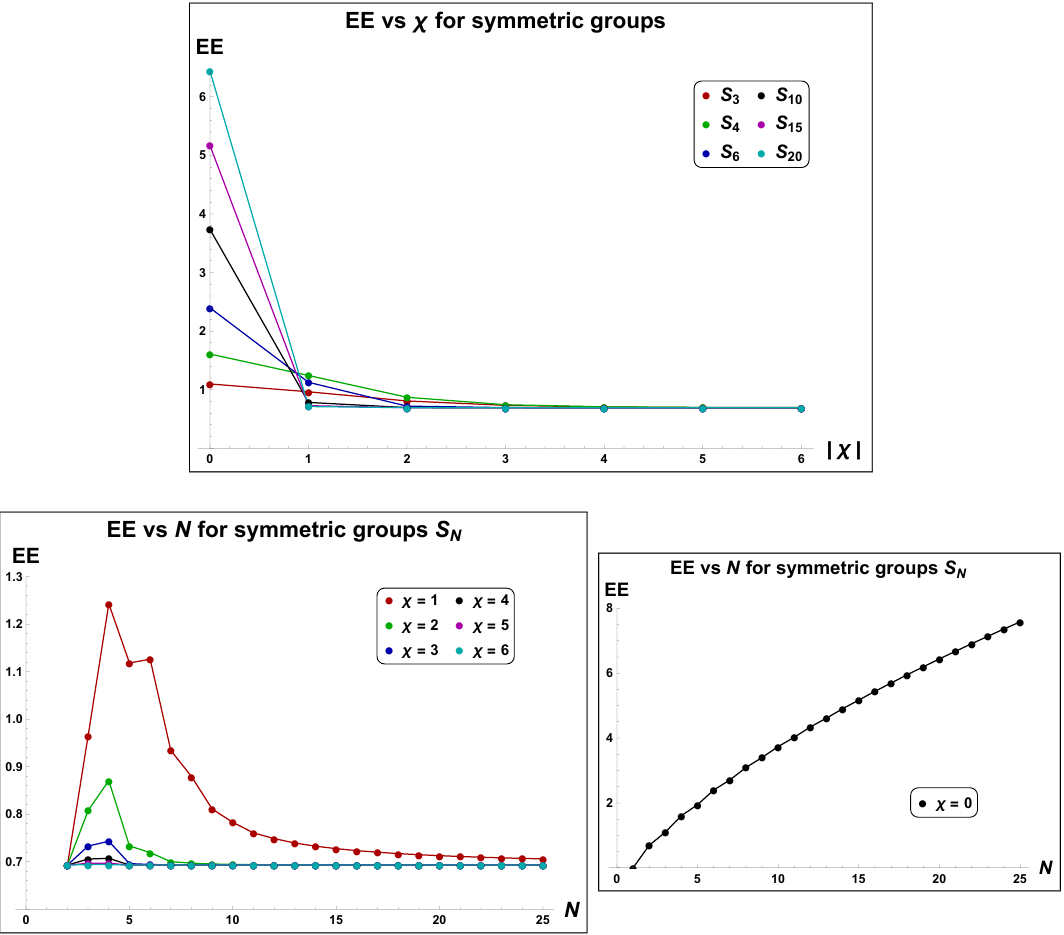
Figure 3 . The variation of entropy for S N groups. For (cid:12)nite N , the entropy monotonically decreases and converge to ln 2 as j (cid:31) j ! 1 . The other two plots show the variation of entropy with N for (cid:12)nite (cid:31) . The (cid:31) = 0 corresponds to maximum entropy.